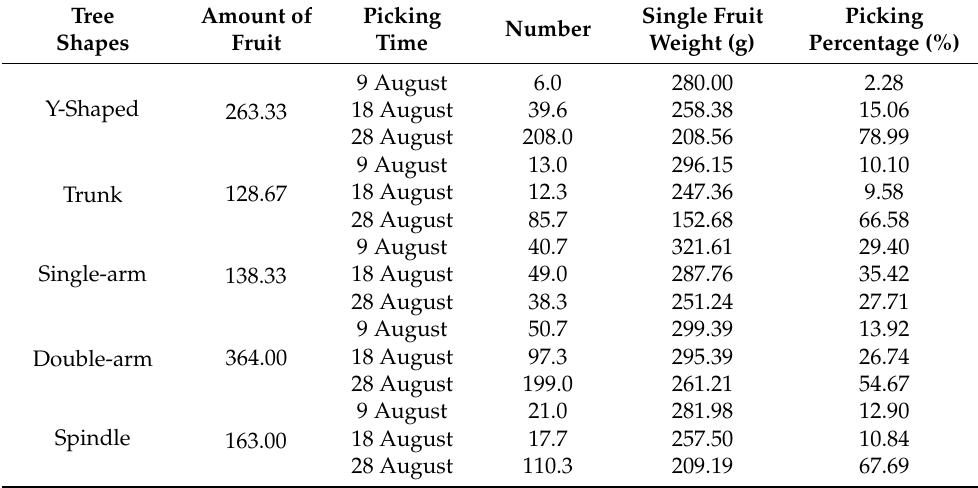
Table 5. Variation in picking times of Zaosu pears with different tree shapes. Tree Amount of Shapes